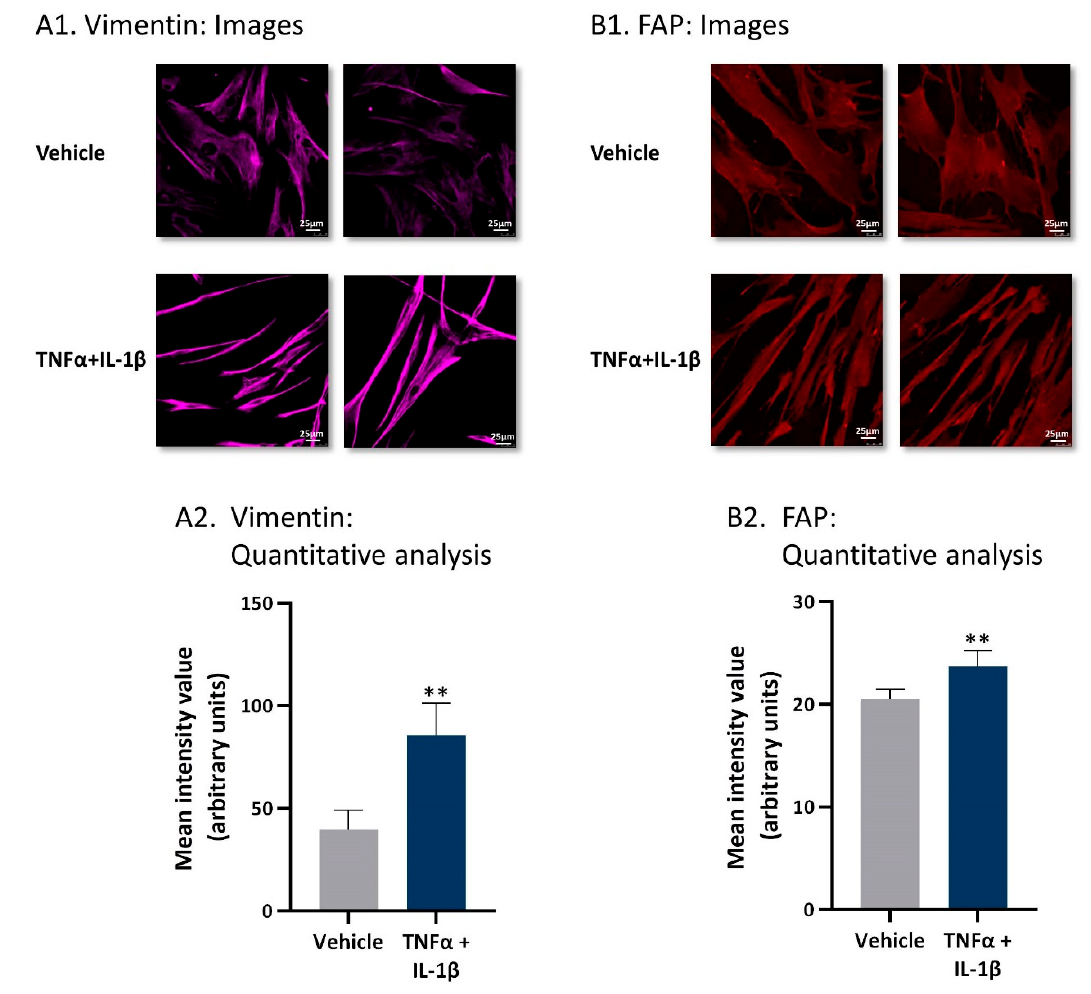
Figure 3. Following persistent stimulation of MSCs with TNF α + IL-1 β , the resulting CAF-like cells express typical CAF markers. Human MSCs were exposed to persistent TNF α + IL-1 β stimulation (concentrations as in Figure 1) or to vehicles, generally for 14–18 days. The expressions of vimentin ( A ) and fibroblast activation protein (FAP) ( B ) were determined by confocal analyses. ( A1 , B1 ) Two representative images are demonstrated for each treatment, derived from a representative experiment out of n = 3. Bar, 25 μ m. ( A2 , B2 ) Quantitative analyses of the fluorescence intensity performed by the ImageJ program on images of the representative experiment ( n ≥ 5 images for each treatment). ** p < 0.01.